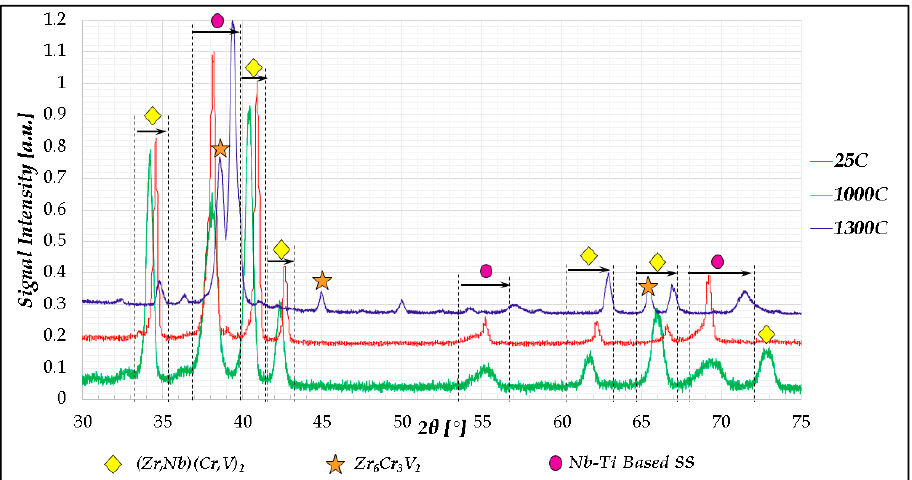
Figure 2 . XRD traces of the Cr 20 Nb 20 Ti 20 V 20 Zr 20 alloy at 25 °C, 1000 °C, and 1300 °C; the shifts in 2 θ Figure 2. XRD traces of the Cr 20 Nb 20 Ti 20 V 20 Zr 20 alloy at 25 ◦ C, 1000 ◦ C, and 1300 ◦ C; the shifts in 2 θ values of certain peaks as a result of the rising temperature are marked in arrows. values of certain peaks as a result of the rising temperature are marked in